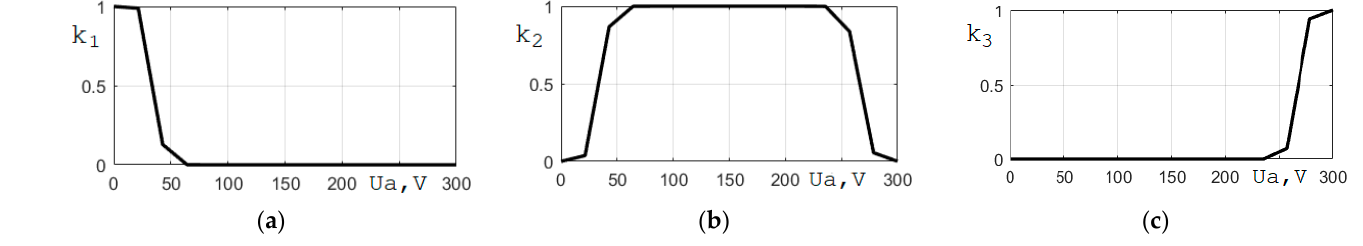
Figure 5. Dependences of fuzzy systems: ( a ) FIS1; ( b ) FIS2; ( c ) FIS3.